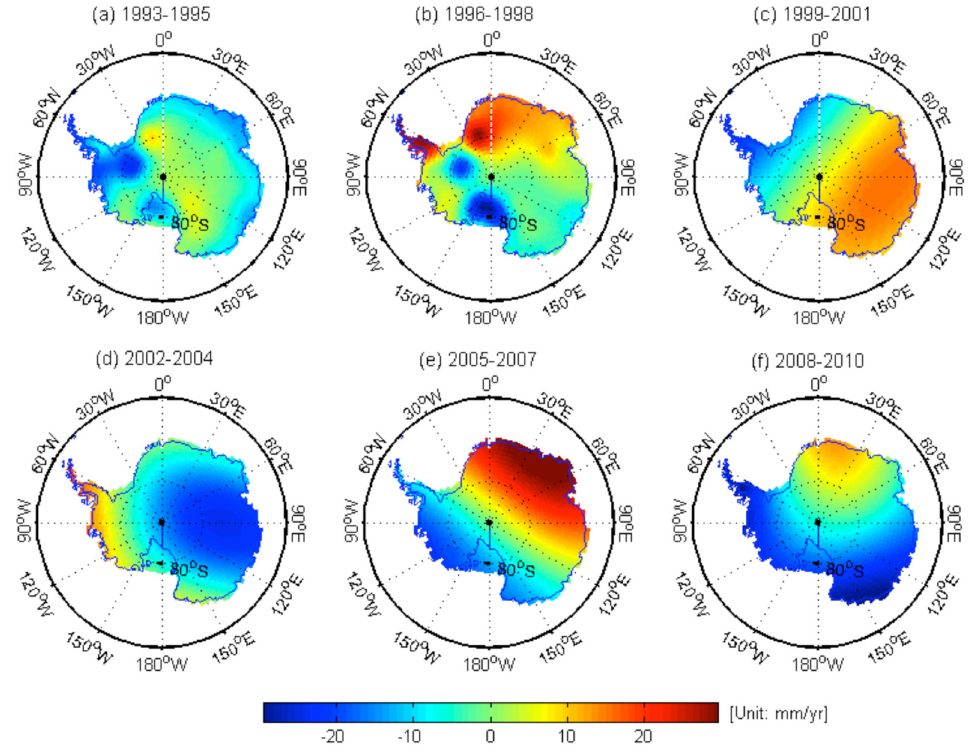
Figure 4. The trends of ice mass variations every 3-year (in mm of equivalent water thickness change) in Antarctica from January 1993 to December 2010 based on SLR